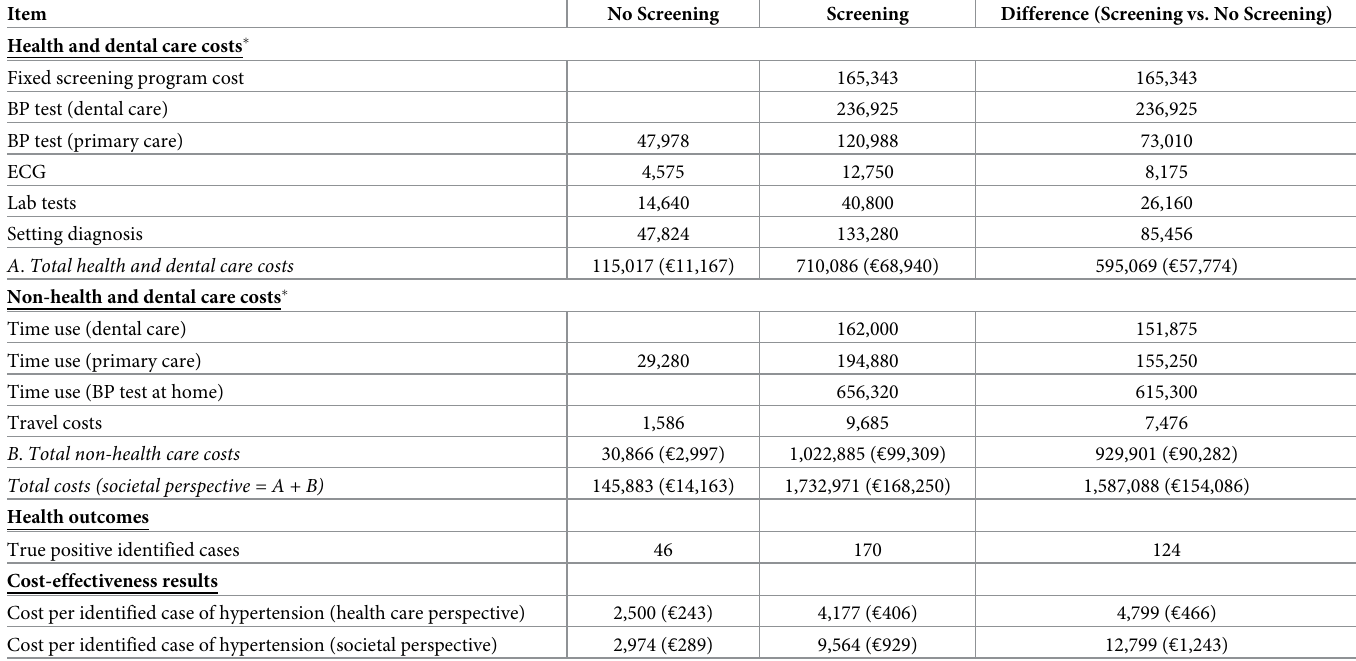
Table 2. Short-term costs and health outcomes for the screening program vs the reference scenario. Costs expressed in Swedish kronor, SEK (Euros in brackets for totals). Item No Screening Screening Difference (Screening vs. No